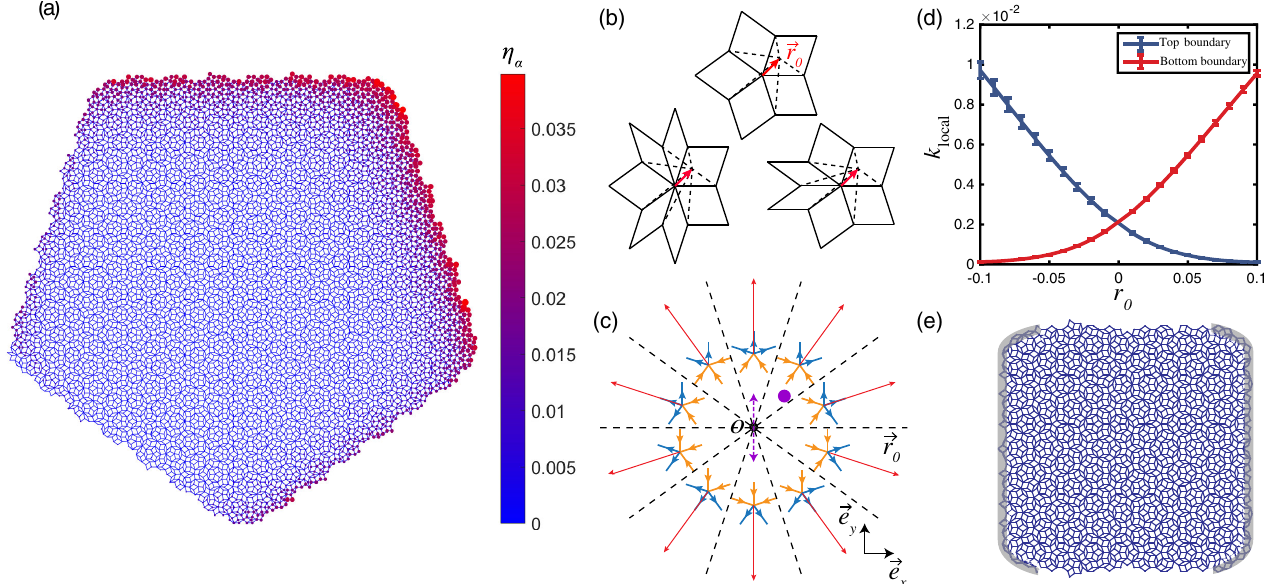
⃗ R FIG. 1. Topological mechanics of the Penrose tiling. (a) A topologically polarized Penrose tiling with T pointing towards the upper right tip of the pentagon (54° from the x axis). Zero-mode weight η α (defined in Sec. III) on each site α is shown using both color (see ⃗ R color bar on the right) and size of the disks. The bottom left boundary, the outward normal of which is opposite to T , is free of floppy modes. (b) Geometric changes we apply on the Penrose tiling to induce the topological boundary floppy modes shown in (a). We choose these z ¼ 5 , 6, 7 vertices (and ones related to these by rotation) in the Penrose tiling and displace them by a small amount ⃗ r 0 ¼ r 0 ˆ e disp with r 0 ¼ 0 . 15 × length of edges in the Penrose tiling and ˆ e cos ψ ; sin ψ Þ with ψ ¼ 45 °. Red arrows show an example of such disp ¼ ð displacements ( r 0 magnified to be visible), which leads to (a). (c) Phase diagram of the resulting topological polarization of strips of parallelograms in the five symmetry directions (short blue outward arrows for n i ¼ 1 and short orange inward arrows for n i ¼ − 1 , where n i is a topological invariant defined in Sec. III for strip topological polarizations), and the topological polarization of the whole modified ⃗ R ˆ e is in each of the ten ranges of Penrose tiling T (long red arrows) as given by Eq. (3.9), as these vertices are displaced. When disp directions defined by the dashed lines, the polarizations are shown by the arrows in that range. The purple dot shows the direction for the ⃗ R k (defined in Sec. III displacements used in (a) which has ψ ¼ 45 °, leading to T pointing towards 54°. (d) Measured local stiffness local and the Appendix H) on opposite boundaries of a topologically polarized Penrose tiling. The setup of the simulation is shown in (e) where we cut a square piece of a polarized Penrose tiling and hold the left and right boundaries fixed (shaded regions). The tiling is polarized by displacing the z ¼ 5 , 6, 7 vertices shown in (b) with ψ ¼ 90 ° [purple arrows in (c) corresponding to r 0 > 0 and r 0 < 0 ], ⃗ R r > 0 and down for r < 0 . The measured local stiffness (d) shows that the boundary that ⃗ R leading to T pointing up for 0 0 T points toward is dramatically softer than the opposite